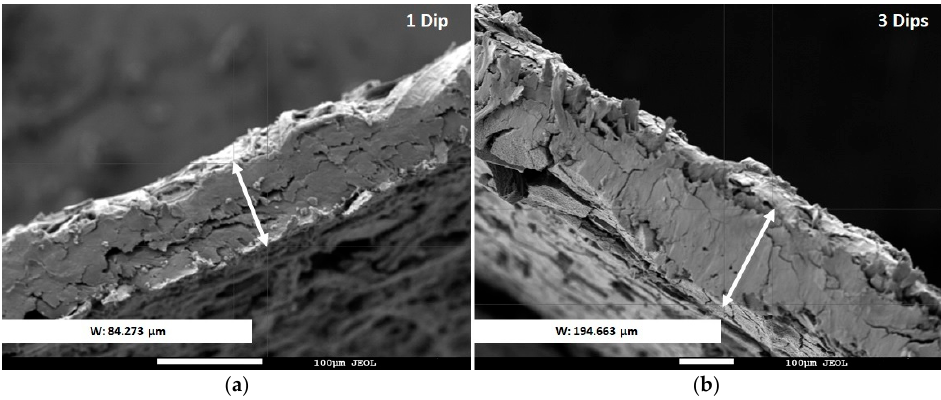
Figure 3. SEM micrographs of the side profile of sorptive phases synthesized after ( a ) one dip (at 270 magnifications) and ( b ) three dips (at 140 magnification). The thickness of the coating (considering the different scale of the pictures) increases from ca. 84 to 190 µm.